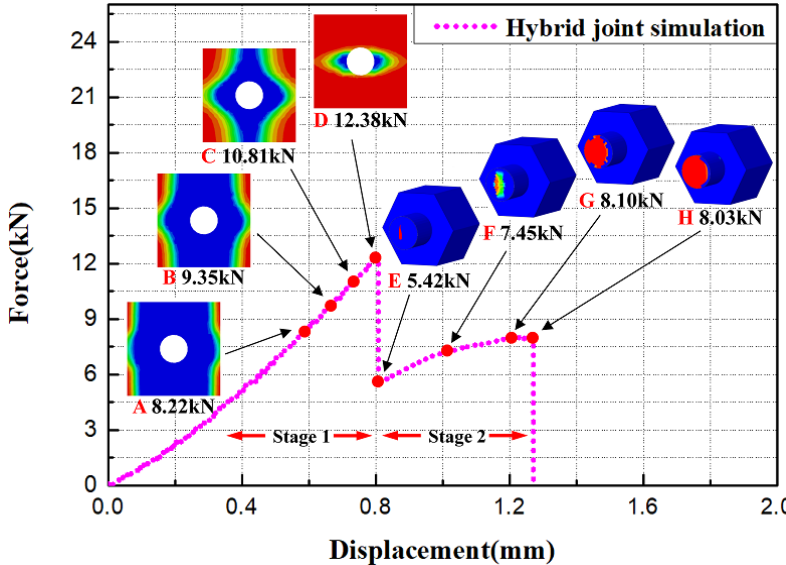
Figure 12. Progressive damage of the hybrid joint.